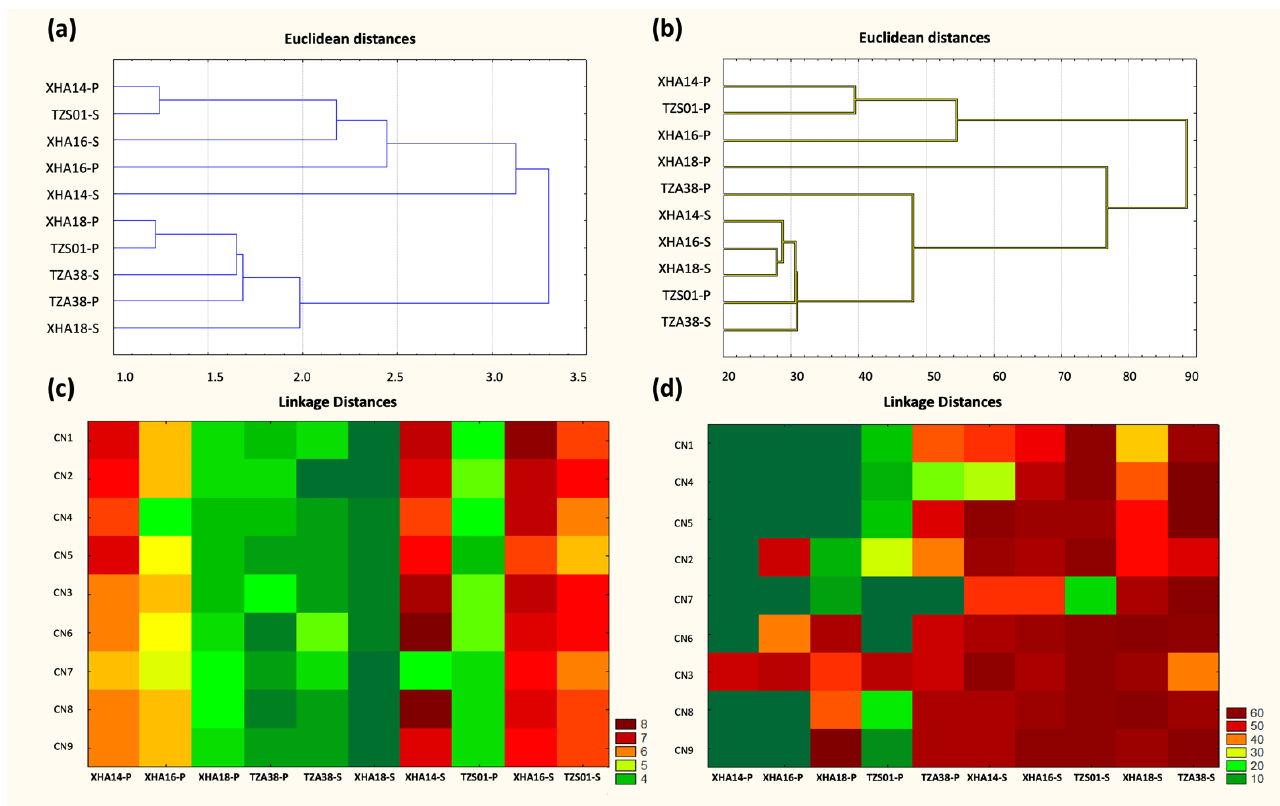
Figure 3. Euclidean distance of the BE ( a ) and BS ( b ) activity, and heat map EI 24 ( c ) and drop-collapse ( d ) of halotolerant bacteria at different concentrations of C/N source in planktonic (P) and sessile (S) cultures.